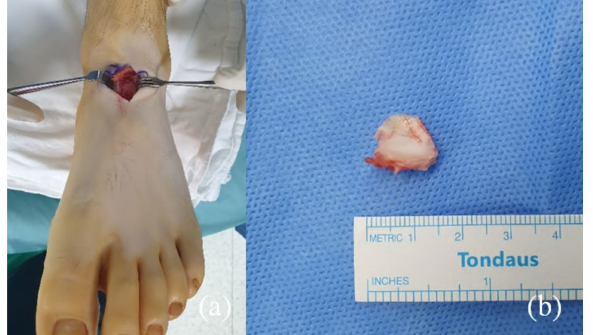
Figure 4. A linear incision was made through an interval between the extensor hallucis brevis (EHB) and the extensor hallucis longus (EHL) tendons ( a ). The diameter of the removed OSSN was measured to be about 1.5 cm ( b